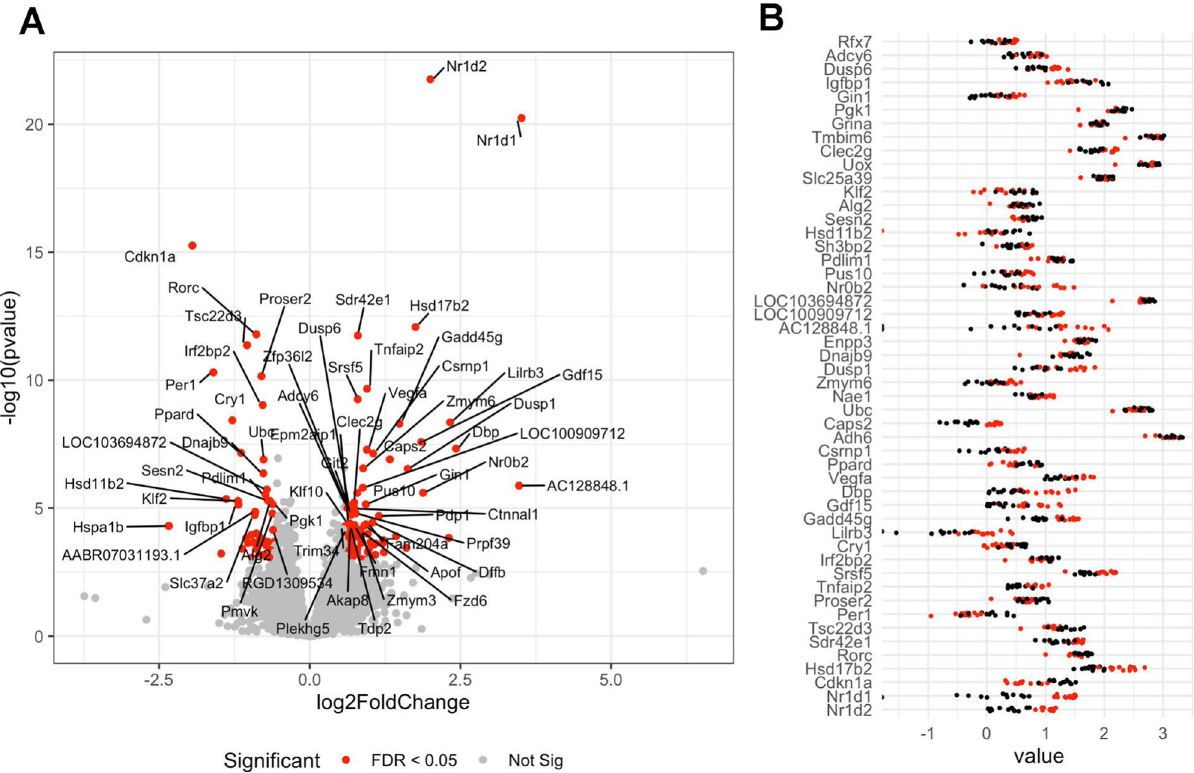
Fig. 5 Liver transcriptomics of Sprague – Dawley rats exposed for 90 days to the mixture of six pesticides. Genes were considered as differentially expressed if their count were found to be statistically signi fi cant after an analysis with DESeq2. A A volcano plot showing the fold changes and statistical signi fi cance in the expression of genes affected by exposure to the pesticide mixture. B The effect size for the 50 most affected transcripts. Log10- normalized abundances from the DESeq2 analysis were used to facilitate the visualization of differences (red dots, pesticide treated; black dots, untreated